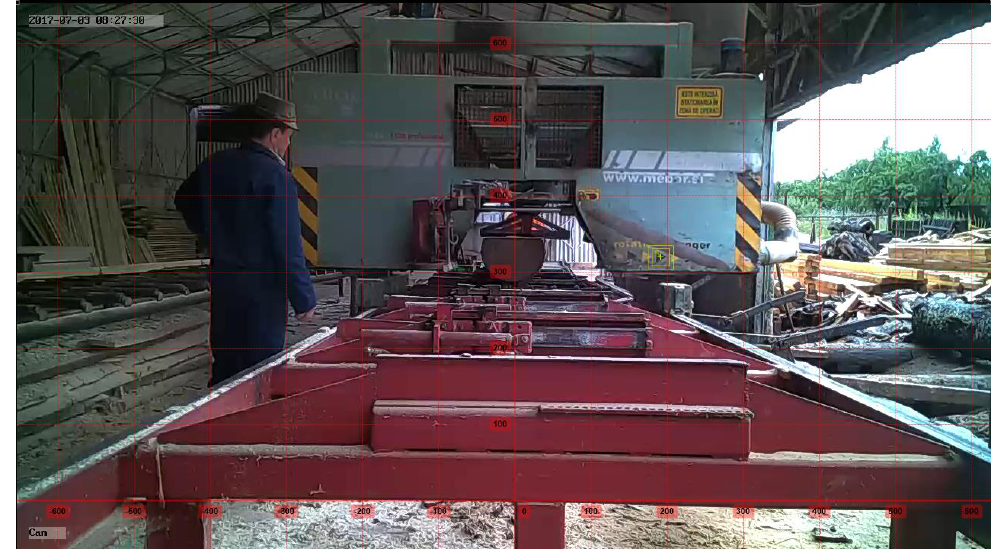
Figure 1. A frame extracted from the Kinovea ® software showing the camera’s field of view, scalar coordinate system (red) and the tracker placement (yellow).